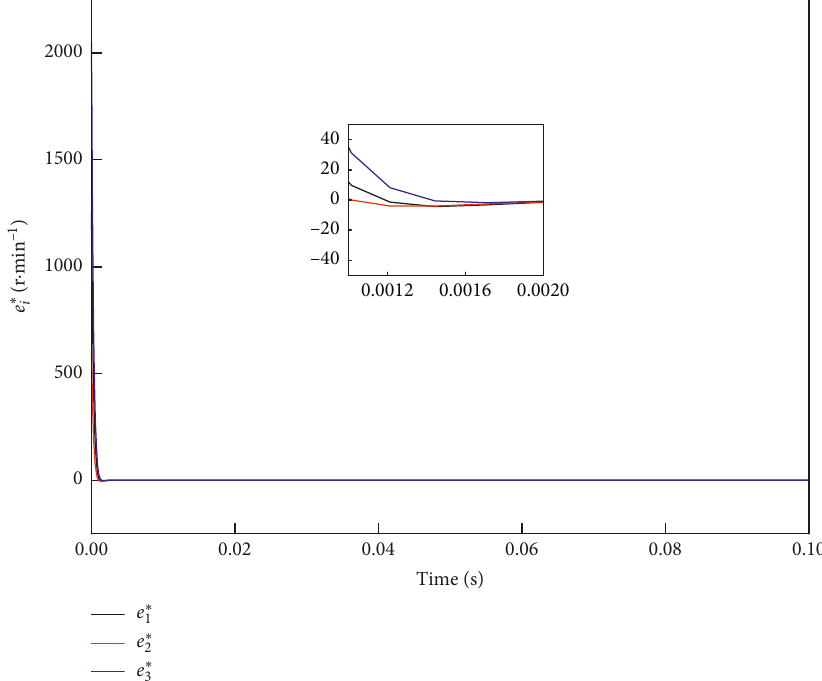
Figure 5: The velocity tracking error curves of all servos under the sliding mode variable control.